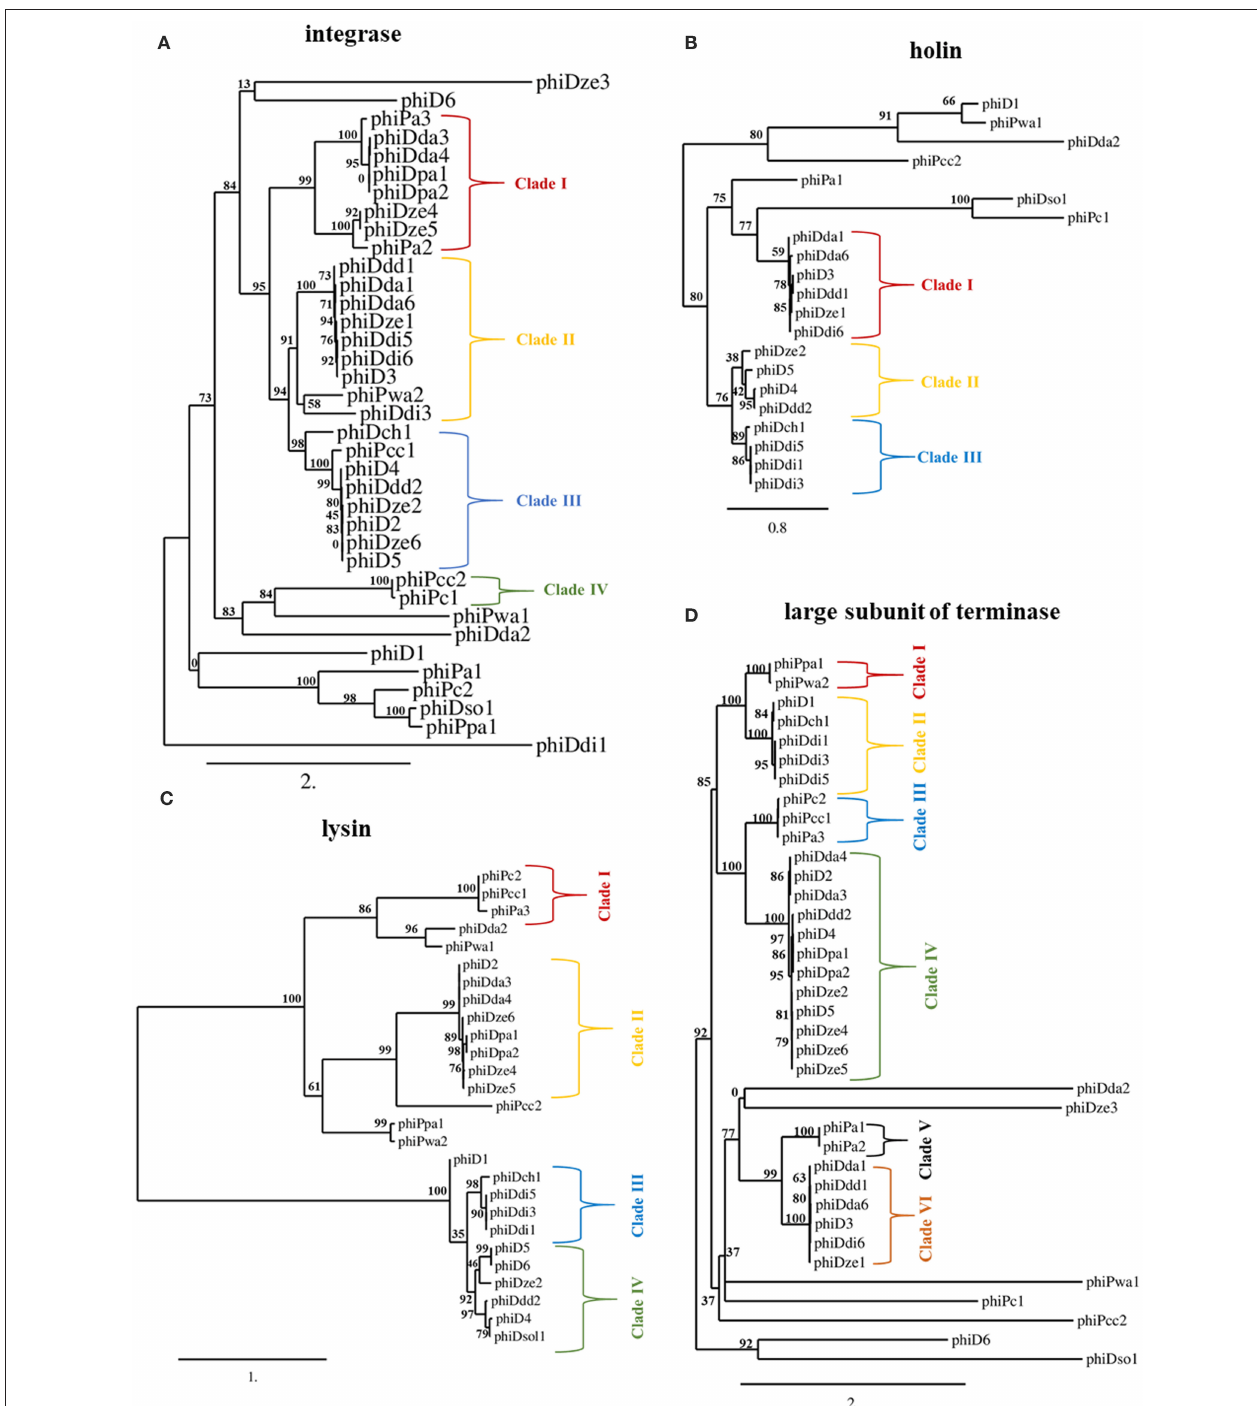
FIGURE 3 | Maximum likelihood (ML) tree based on the aligned amino acid sequences of integrase (present in 37 prophages) (A) , holin (present in 21 prophages) (B) , lysin (present in 27 prophages) (C) and large subunit of terminase (present in 37 prophages) (D) genes of seemingly intact prophage sequences distributed in 57 Soft Rot Pectobacteriaceae genomes. Phylogenetic studies were performed using Phylogenetic Pipeline of Information Génomique et Structurale, CNRS-AMU, France (http://www.phylogeny.fr/) with bootstrap support for 1,000 replicates. The bar indicates the number of substitutions per sequence position. The cutoff for separating the clades was the bootstrap support for particular branch (n) of at least 70% together with the bootstrap support for particular predecessor branch (n-1) of at least 70%.